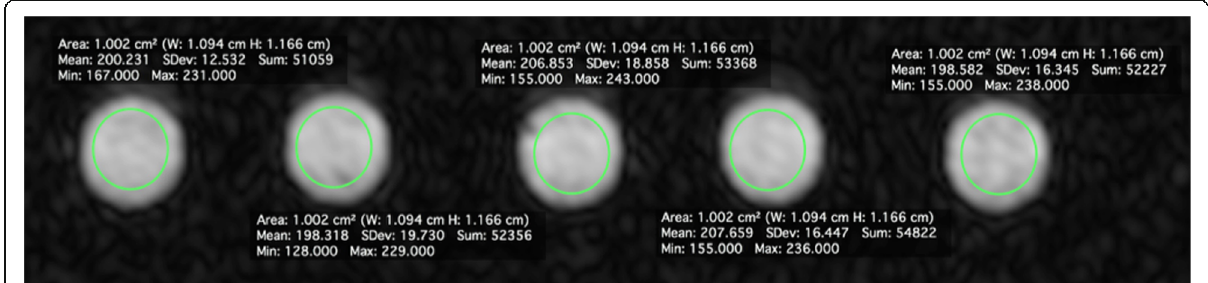
Fig. 2 MRA axial images of the five 10-mL syringe filled concentrated pineapple juice plus modified potato starch